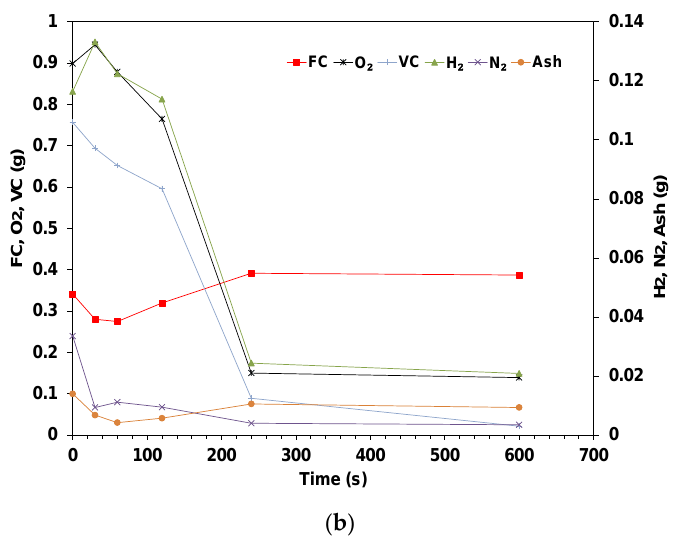
Figure 7. Elemental analysis of wood pellets at 444 °C: ( a ) in percentages and ( b ) in grams.